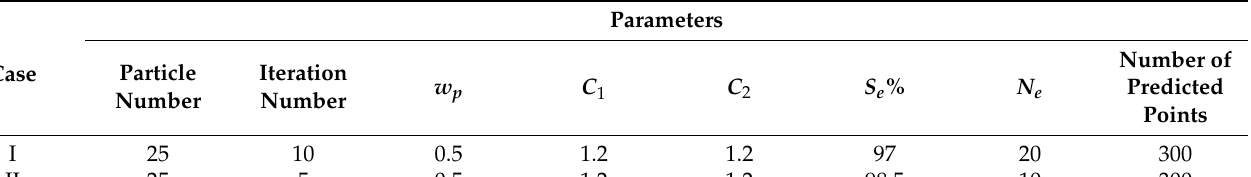
Table 5. Two parameter settings of PSO algorithm.